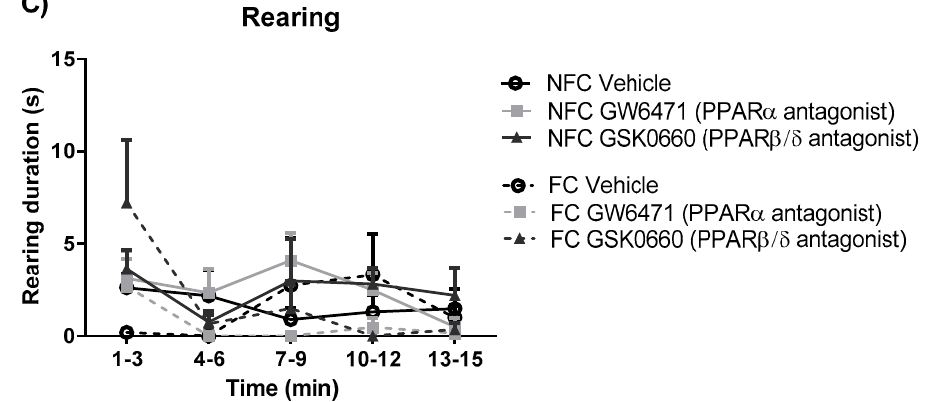
Figure 4. Effects of fear ‐ conditioning and systemic administration of selective PPAR α and PPAR β / δ antagonists on walking duration ( A ), grooming duration ( B ), and rearing duration ( C ). Data (mean ± S.E.M) are represented in 3 ‐ min time bins ( n = nine rats per group). According to a repeated measured ANOVA ( p < 0.05), * significant main effect of fear conditioning.